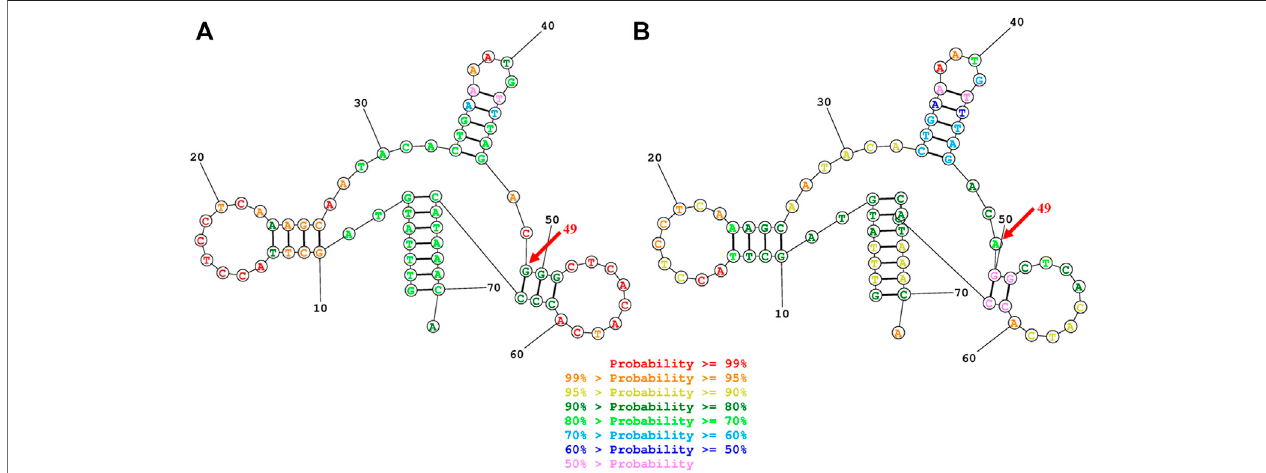
FIGURE 2 | Secondary structure prediction of tRNA Phe by the Web Servers for RNA Secondary Structure Prediction (http://rna.urmc.rochester.edu/ RNAstructureWeb). (A) G49 residue formed a G-C base pairings in the T-stem of the mitochondrial tRNA Phe gene (B) The 625G > A mutation damaged the G-C Base pairing at the 49 residues and leads to a disruption of the secondary structure of the tRNA after the loss of the T-stem.